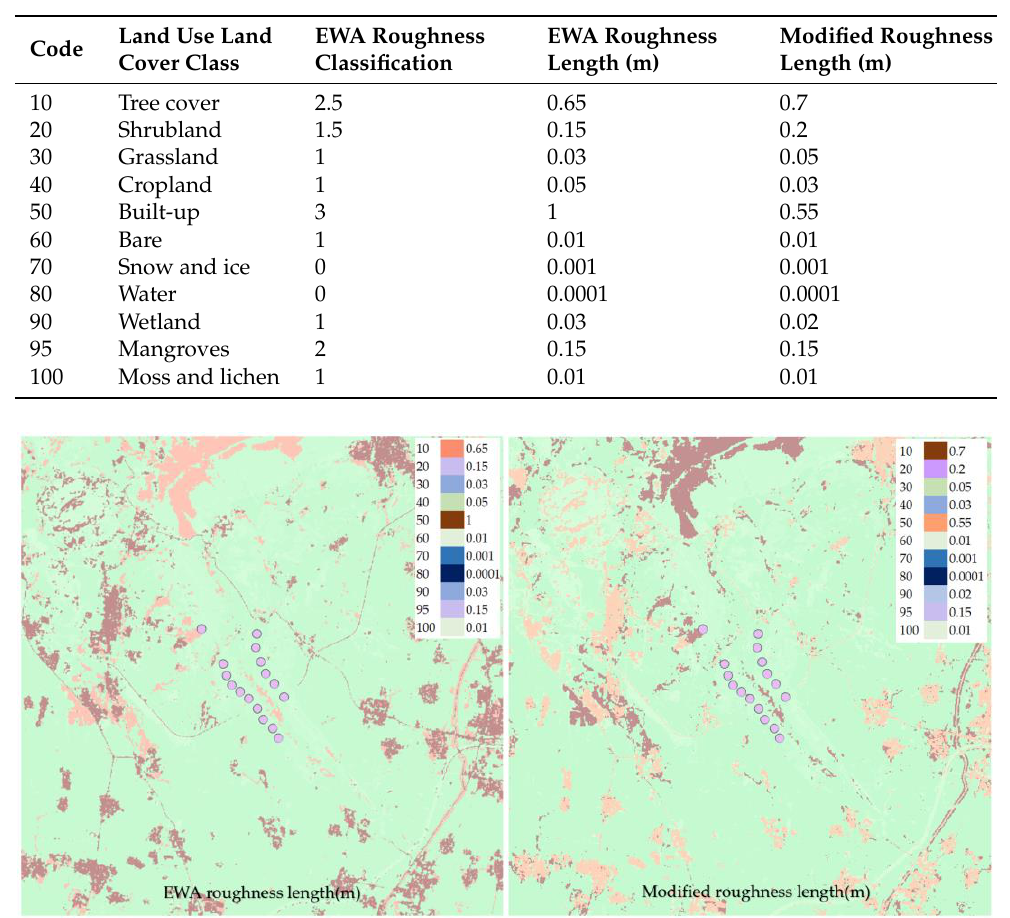
Table 1. Roughness length.